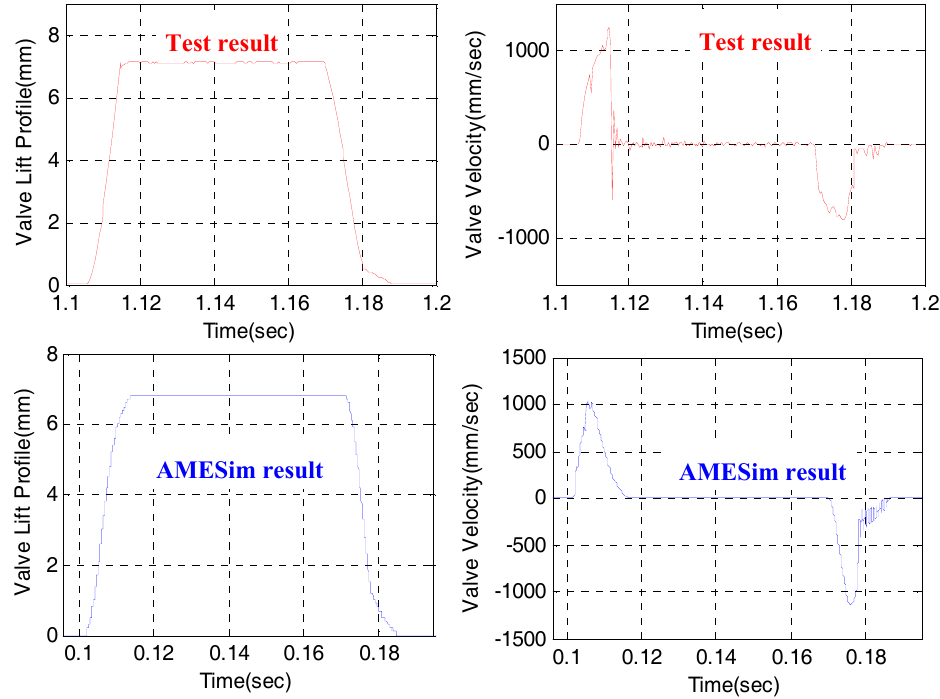
Figure 13. Comparison of valve responses for real EH-CEVA and AMESim model.